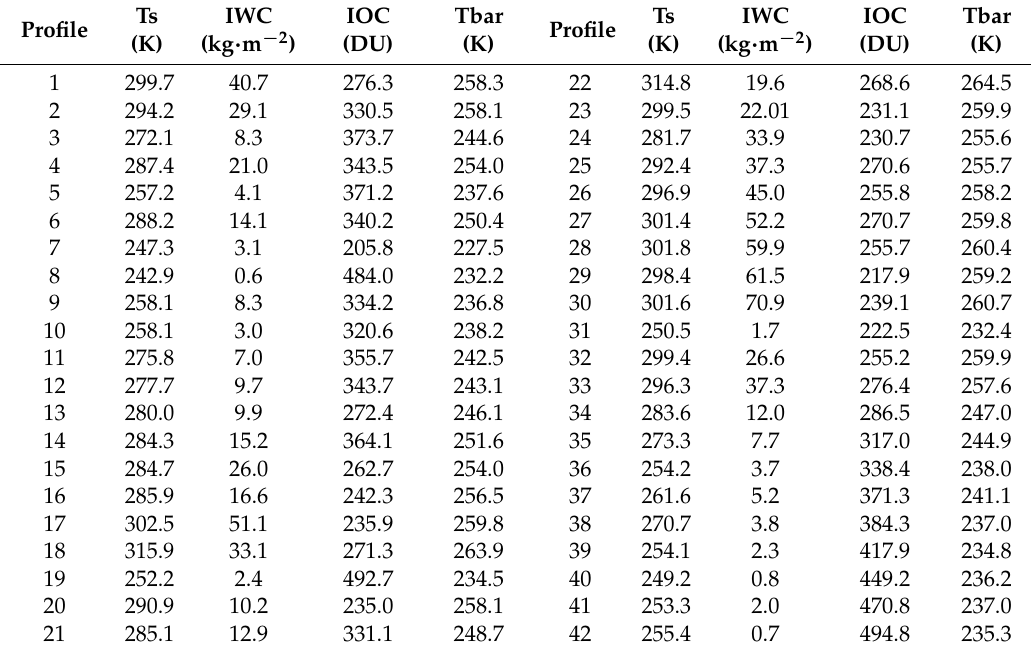
Table 5. Atmospheric profile characteristics in terms of surface temperature (T s ), Integrated Water Content (IWC), Integrated Ozone Content (IOC), and Mean Atmospheric Temperature (T bar